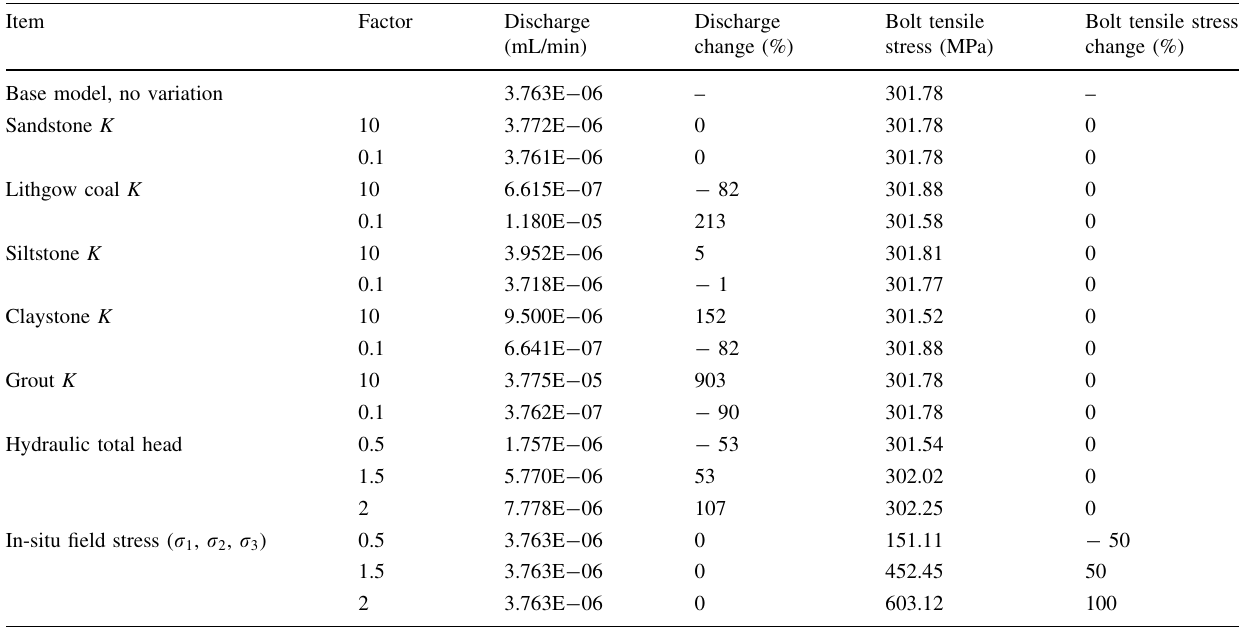
Table 4 Sensitivity analysis